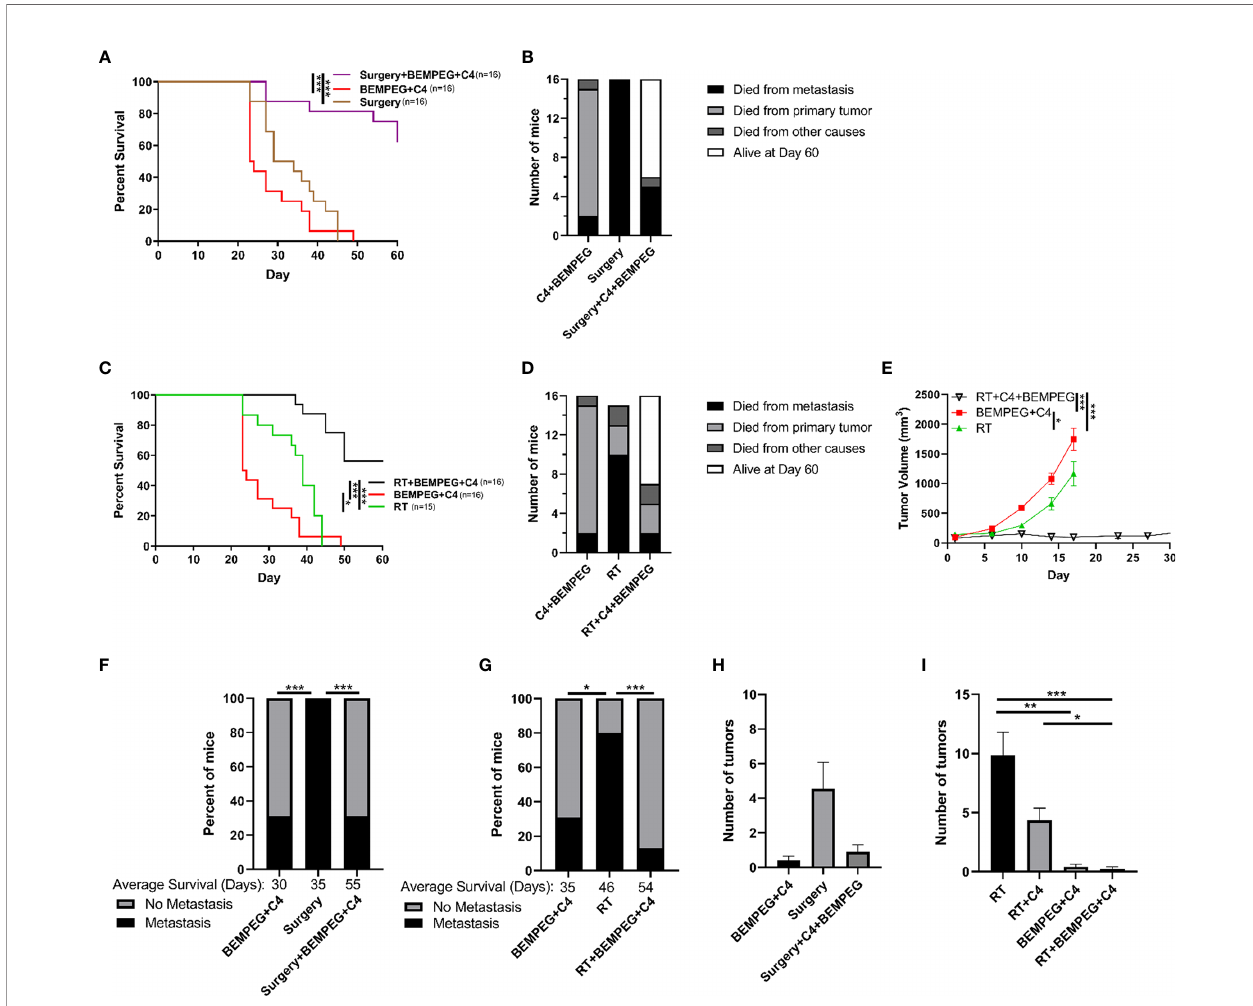
FIGURE 2 | BEMPEG and anti-CTLA-4 reduce metastatic spread in a disseminated LLC model. Mice bearing a LLC primary fl ank tumor (80mm 3 on day 1) received an IV injection of 2x10 5 LLC cells on day 10 after treatment initiation with 8 Gy x 3 daily fractions (days 1, 2, 3) or surgical resection (day 16). This local treatment was combined with BEMPEG and anti-CTLA-4 (C4) treatments. (A, C) Survival curves (Kaplan – Meier and Log-rank pairwise comparison with Benjamini- Hochberg adjustment for p-values, n ≥ 9, 2 independent animal experiments) are shown. (B, D) Cause of death is graphed for mice receiving the indicated treatments. (E) Tumor volume growth curves are shown (linear mixed effects model, mean ± SEM, n=10, replicate experiment and individual mouse growth curves are shown in Supplemental Figure 7 ). (F, G) At the time of death, metastatic disease was determined via India ink staining of the lungs. Fisher ’ s exact test and a post-hoc pairwise comparison with Benjamini-Hochberg adjustment for p-values were used for statistical analyses. At day 22 (H) and day 35 (I) mice were euthanized (replicate experiments in Supplemental Figure 8 ), lungs were harvested, and India ink stained as shown in Supplemental Figure 1A , and lung metastatic tumor burden was quanti fi ed. ***=P<0.001; **=P<0.01;